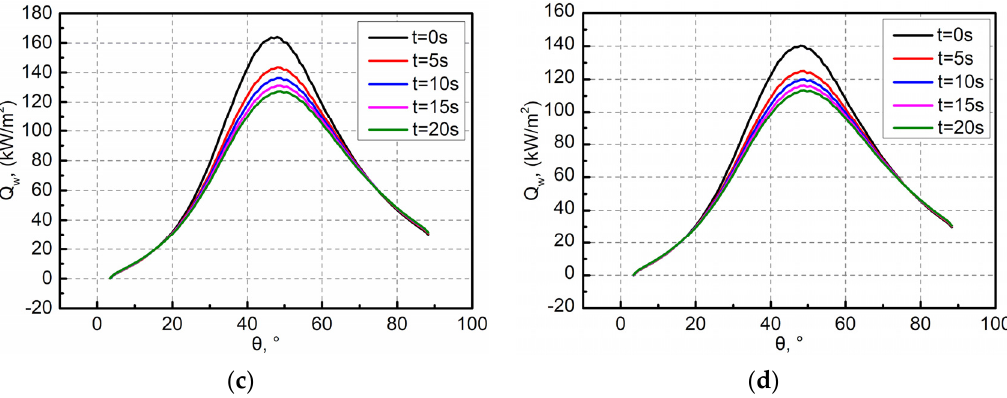
Figure 11. Evolution of wall heat flux of the forebody: ( a ) Model 1; ( b ) Model 2; ( c ) Model 3; ( d ) Model 4.